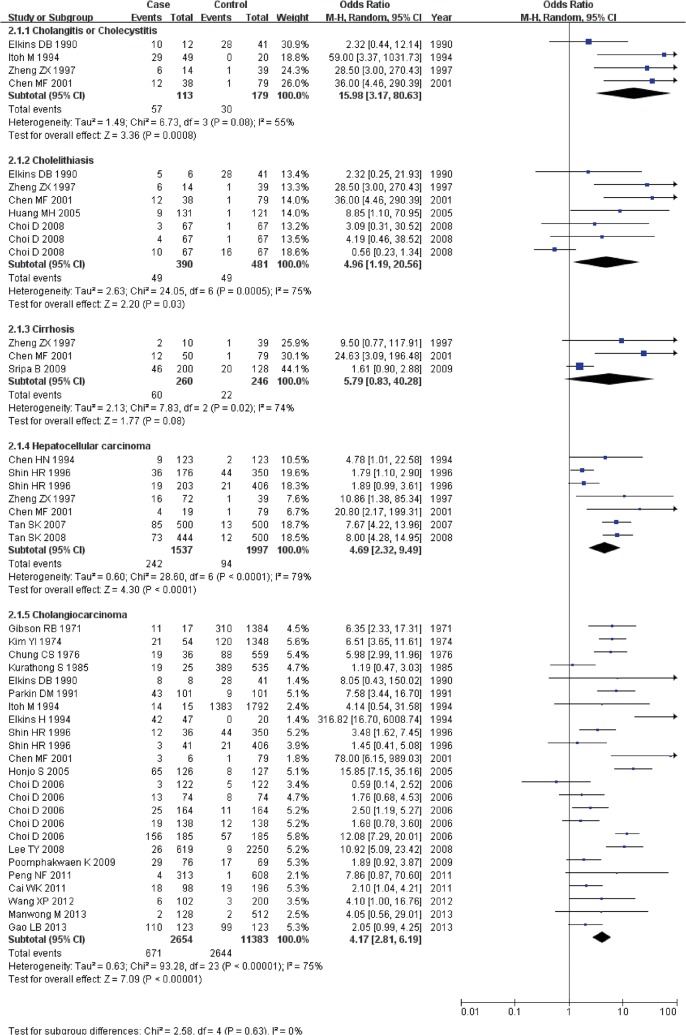
Forest plot of case-control studies on the relationship between liver fluke infection and various hepatobiliary pathological changes.